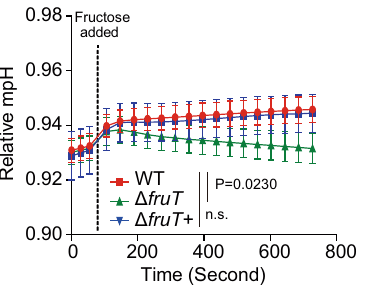
Fig. 2 Fructose symport activity of FruT. Effect on the extracellular pH elicited measured before and after the addition of fructose to a fi nal concentration of 30 mM to unbuffered aqueous cell suspensions of WT, Δ fruT , and Δ fruT + . The extracellular pH was measured by Seahorse XF analyzer. The dotted lines indicate the times of fructose addition. Data are shown as the mean ± SD ( n = 3). Signi fi cance is determined by two-way ANOVA and indicated as the P value; n.s. means no signi fi cant difference. Source data are included in Source Data fi may encode a fructose transporter. Consequently, vca0669 was